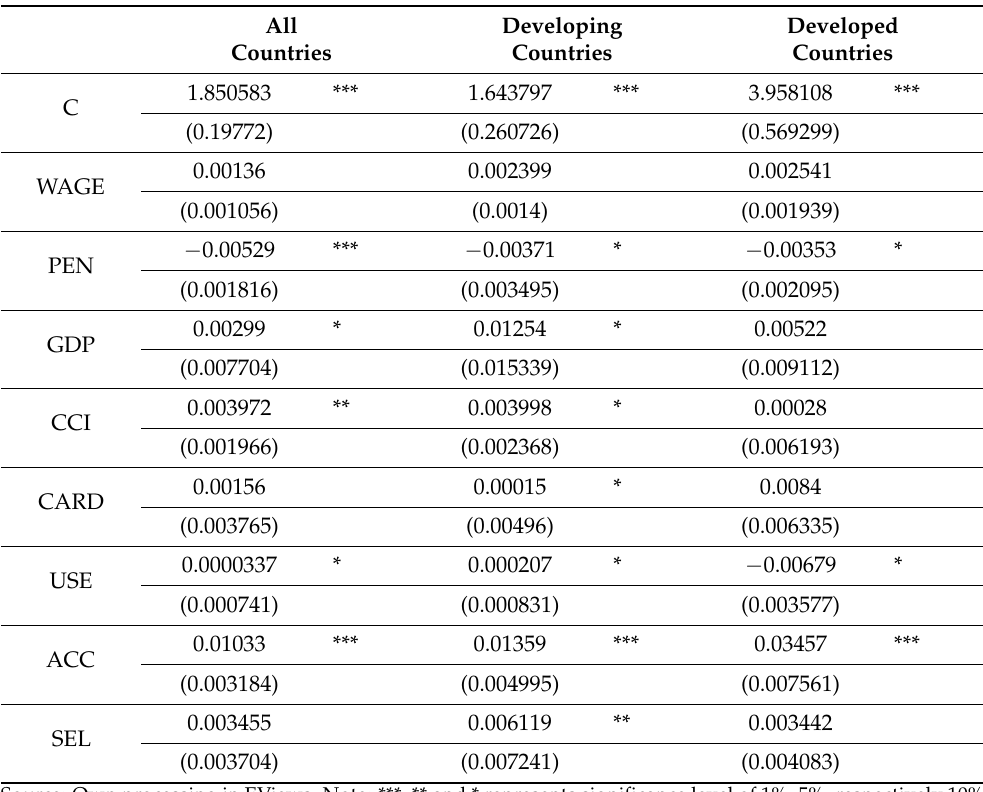
Table 1. Empirical